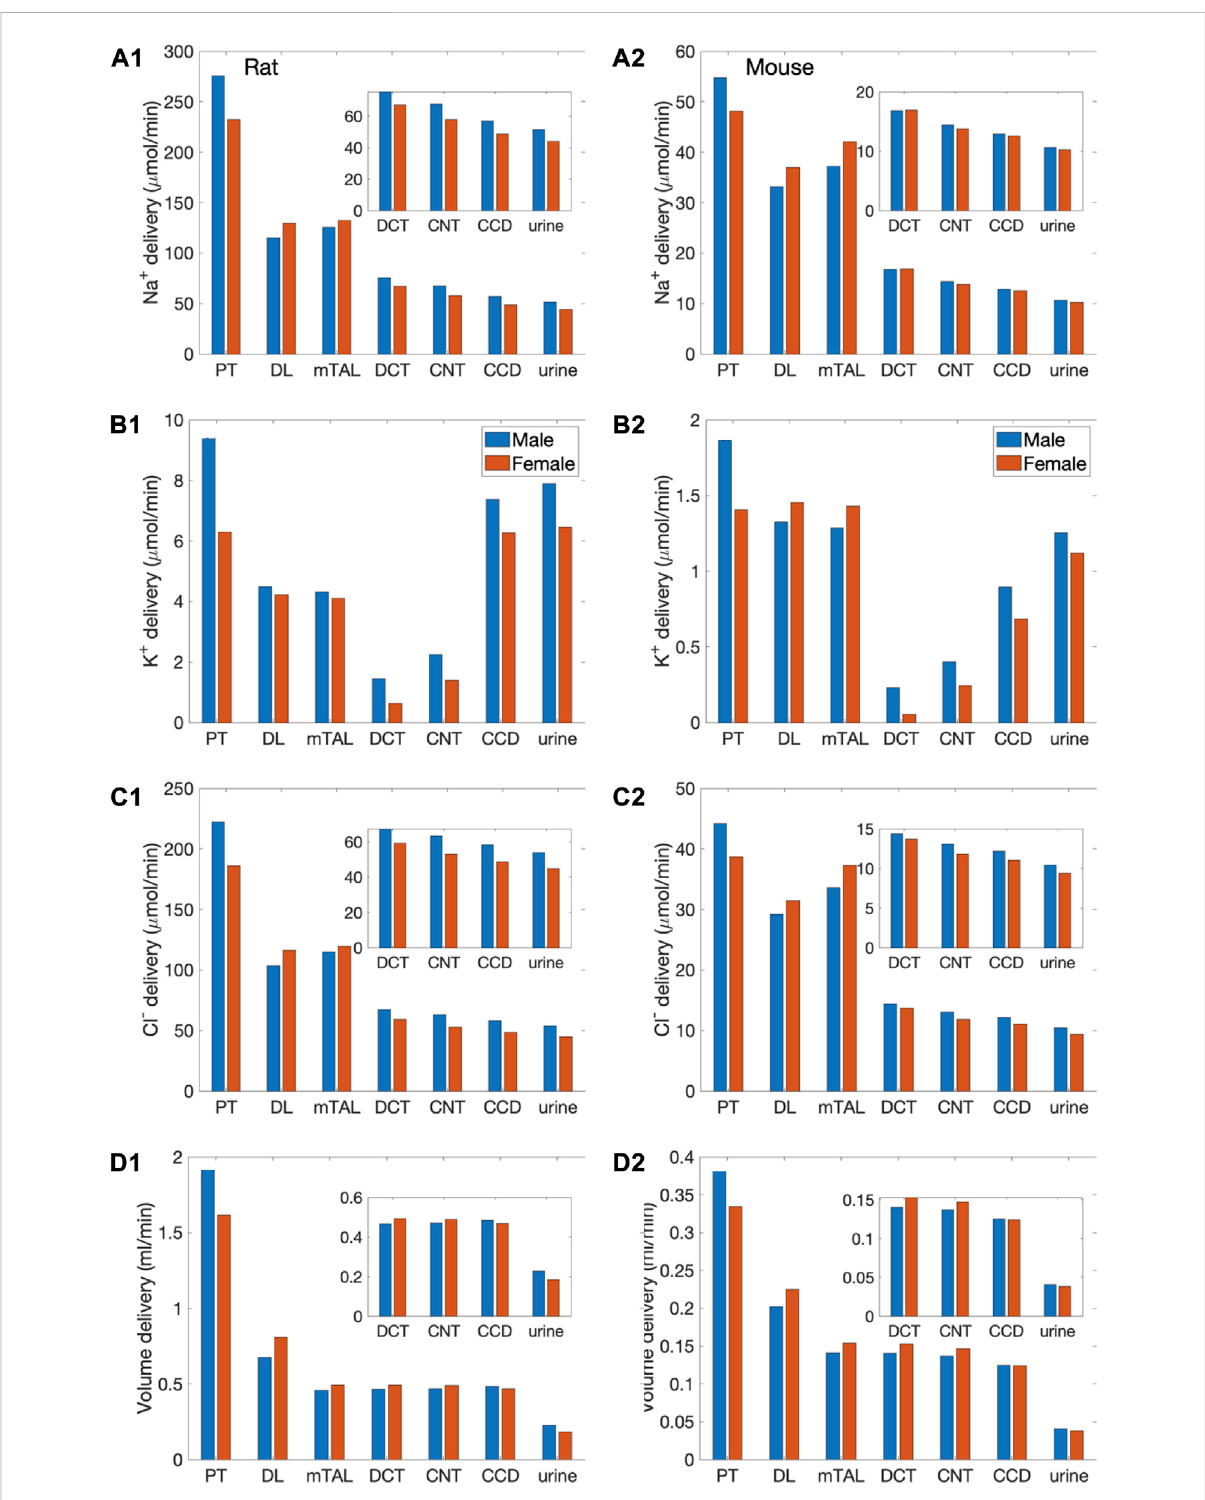
Deliveryofkeysolutes and fl uidtothebeginningofindividual nephronsegments inmale andfemalerats (A1 , B1 , C1 , D1) andmice (A2 , B2 , C2 , D2) following a saline load. Notations are analogous to Figure 2. Insets: magni fi ed reproductions of distal segment values. The predicted excretion rates are lower for the female models relative to the respective male model. However, when scaled by bolus volume, the female rat model excretes the bolus faster than the male rat